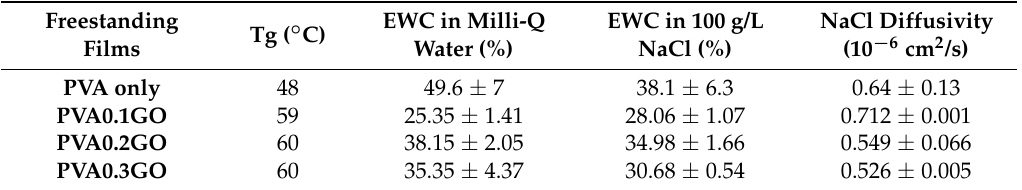
Table 3. Thermal and swelling property of the freestanding films (PVA0.1GO denoted membrane